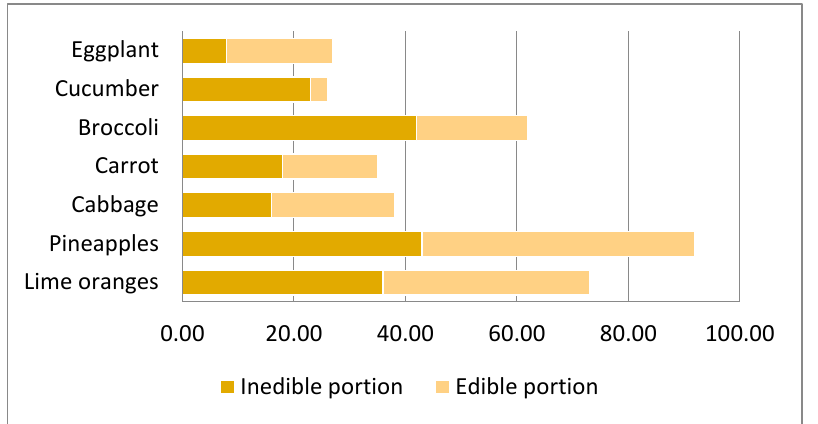
Figure 5. An estimation of edible and inedible fractions (%) resulting from some of the widely available food products in the market.